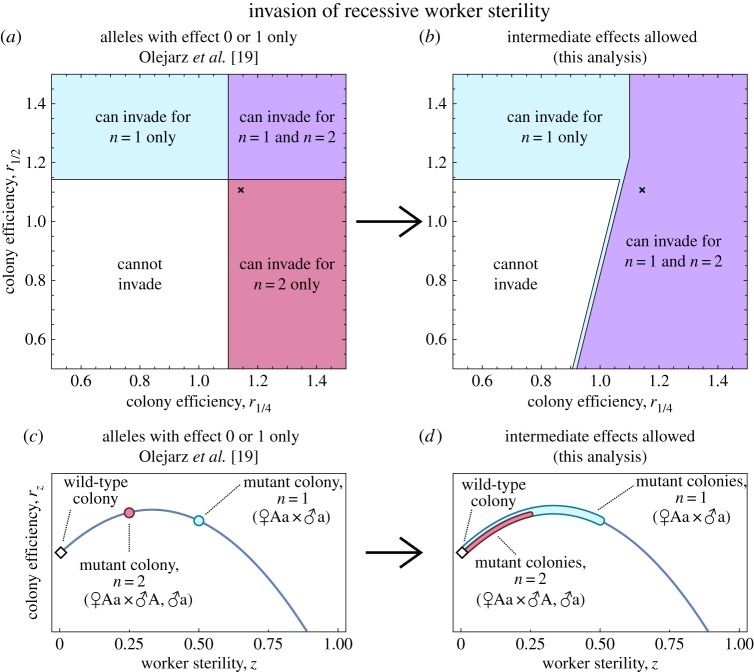
The invasion of worker sterility under recessive genetics, showing where sterility can invade under single mating (n=1) only, double mating (n=2) only, both, or neither, as a function of the colony efficiency values r0=1, r1/4 and r1/2. (a) If we assume that only full-sterility alleles can arise, as Olejarz et al. [19] did, double mating sometimes promotes the invasion of sterility relative to single mating. But (b) if we assume that alleles encoding any level of intermediate worker sterility may arise, double mating never promotes the invasion of sterility relative to single mating. This is because (c) for a rare allele encoding full sterility, mutant colonies have the phenotype z=12 under single mating and z=14 under double mating. Therefore, sterility may invade more easily under double mating if colony efficiency is relatively peaked near z=14. But (d) for a rare allele encoding intermediate sterility, mutant colonies may express any phenotype 0<z≤12 under single mating and 0<z≤14 under double mating, depending on the allele’s penetrance or effect, and so mutant phenotypes are less constrained by the population’s mating number. To facilitate comparison with fig. 3A of Olejarz et al. [19], we assume pz=0.2+0.8z. For rz, we use the unique quadratic curve passing through the points specified by r0=1, r1/4 and r1/2, but the result that single mating always promotes the invasion of recessive, non-spiteful sterility relative to double mating holds regardless of the shape of the rz curve passing through these points.